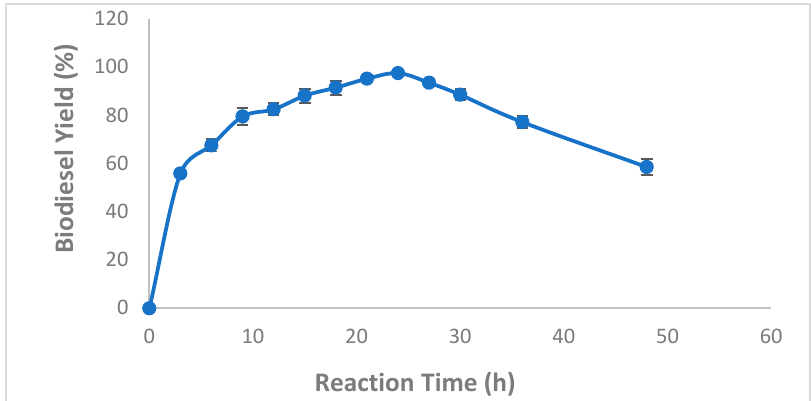
Figure 6. Effect of reaction time on mixed CaCO 3 -immobilized-lipase catalyzed transesterification process of waste cooking oil (WCO) for biodiesel synthesis. Experimental conditions were: methanol/oil molar ratio: 6:1, lipase loading 1%, water content 5%, reaction temperature 55 °C, agitation speed 150 rpm. Experiments were performed in triplicate and error bars indicate mean ± standard